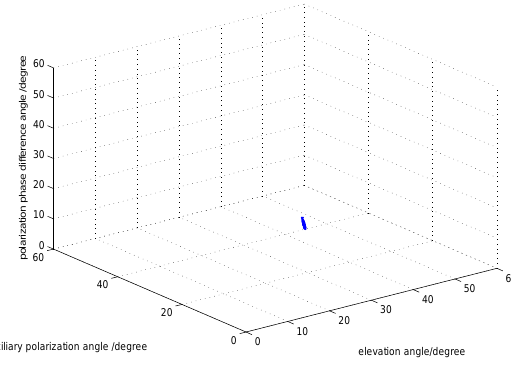
Figure 8. The DOA and polarization estimation after the filtering with fixed SNR